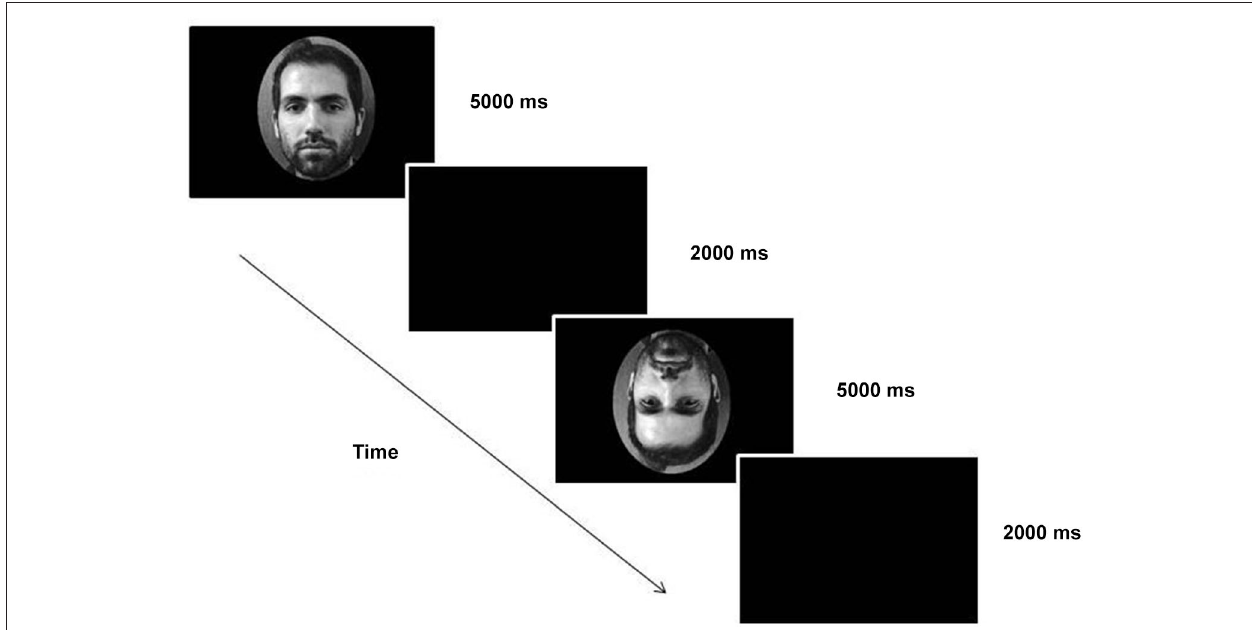
FIGURE 2 | Example of experiment .